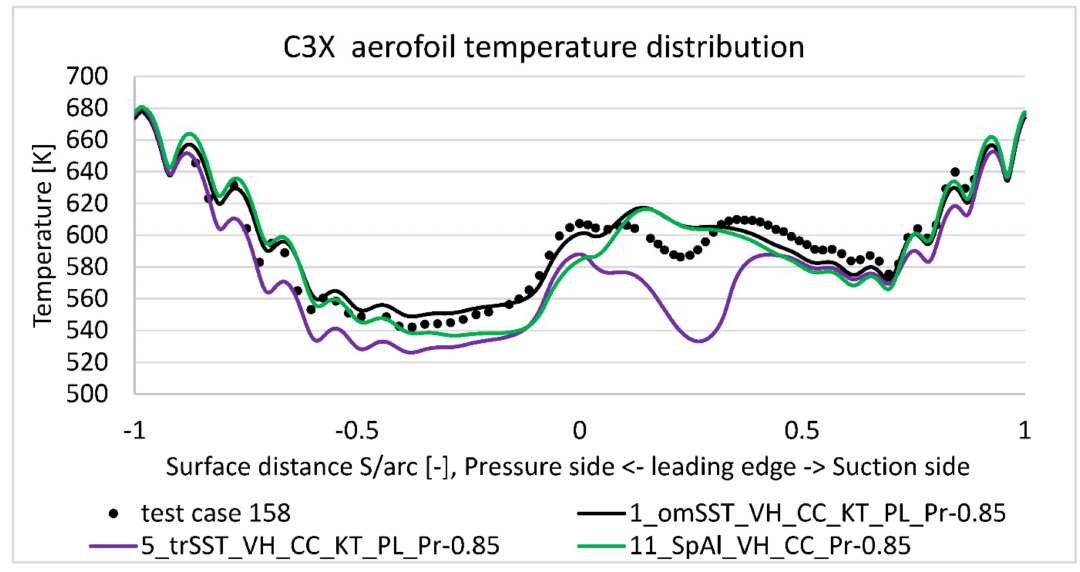
Figure 8. Predicted vane external surface temperature at midspan versus experimental results (measurement uncertainty is ± 11